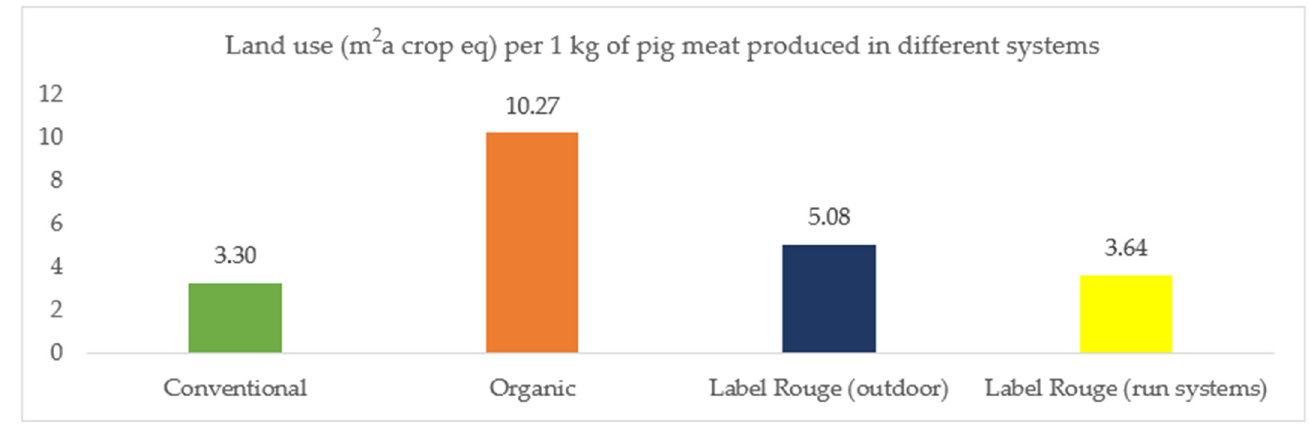
Figure 5. Land use required per 1 kg Pig meat across organic, Label Rouge and Conventional systems: Data obtained from AGRIBALYSE ® database and computed using OpenLCA 1.10.2 [35,36].